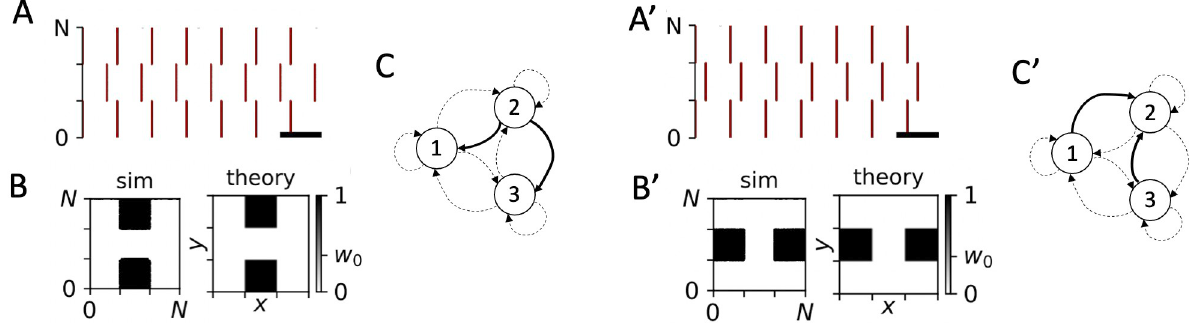
Fig 11. PMCS-induced tree and reverse-tree network structures. A: Raster plot of the spiking activity in the LIF network model 1000 sec after onset of PMCS with single-pulse stimuli and small positive phase lags between stimuli delivered to subpopulation two and subpopulations one and three. B: A snapshot of the synaptic weight matrix after 1000 sec of stimulation (sim) and the corresponding theoretical prediction obtained from Eq 1 (theory). C: Schematic of stimulation-induced tree network structure (see caption of Fig 9 for symbols). A’-C’: Same as A-C but for single-pulse PMCS with small negative phase lags between stimuli delivered to subpopulation two and subpopulations one and three. Parameters: A stim = 0.4, f = 10 Hz, and d e = 1 (all panels) and Δ α 1 = 0.7, and Δ α 2 = 0.3 (A-C), and Δ α 1 = 0.3, and Δ α 2 = 0.7 (A’-C’).